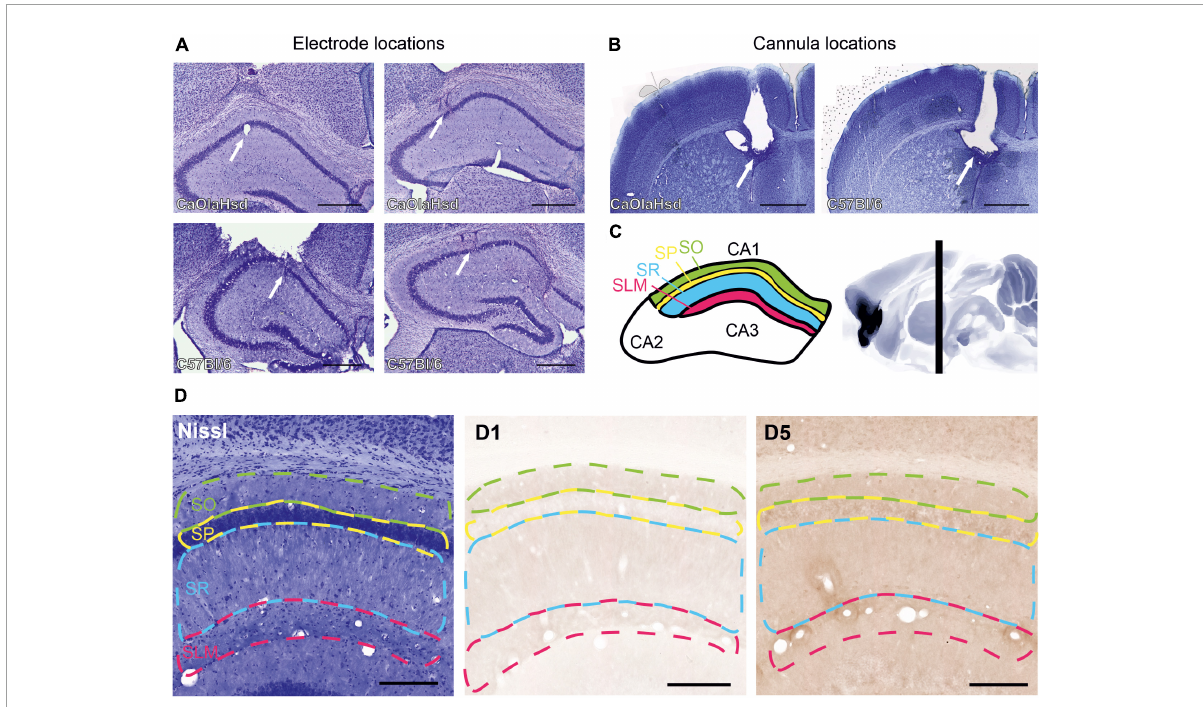
FIGURE1 Histological verification of the position of the cannula, recording and stimulation electrodes and illustration of the regions for immunohistochemical analysis. (A) Nissl-stained photographs show the position of the monopolar recording electrode in the stratum radiatum in CA1 (white arrow in the left panels) and the bipolar stimulation electrode in the Schaffer-collateral pathway (white arrow in the right panels) in CaOlaHsd (top row) and C57Bl/6 mice (bottom row). Scale bar = 500 µ m. (B) Nissl-stained photographs show the position of the cannula within the ventricle in CaOlaHsd mice (white arrow in the left panel) and in C57Bl6 mice (white arrow in the right panel). Scale bar = 500 µ m. (C) Schematic figure of the dorsal hippocampus depicting CA1 delineations used to analyze the laminar distribution of the D1-like receptors. The colored regions correspond to the different layers shown in (D). Green: stratum oriens, SO; yellow: Stratum pyramidale, SP; blue: Stratum radiatum, SR and magenta: stratum lacunosum moleculare, SLM). The right panel shows a sagittal cut of the brain. The vertical black bar denotes the position (AP –1.8 mm) used for immunohistochemical analysis. (D) Left panel shows a Nissl-stained brain slice that indicates the different layers used for immunohistochemical analysis. The middle and right panels show immunohistochemical stainings of D1 and D5 receptors, respectively, within the same brain slice shown in the left image. Dashed green line: stratum oriens, dashed yellow line: stratum pyramidale, dashed blue line: Stratum radiatum, dashed magenta line: Stratum lacunosum moleculare. Scale bar = 50 µ